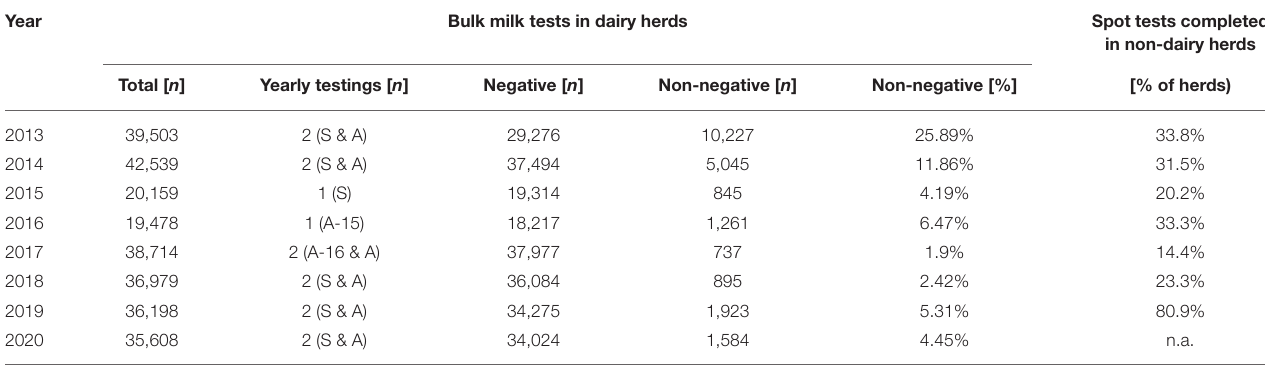
Year Bulk milk tests in dairy herds Spot tests completed